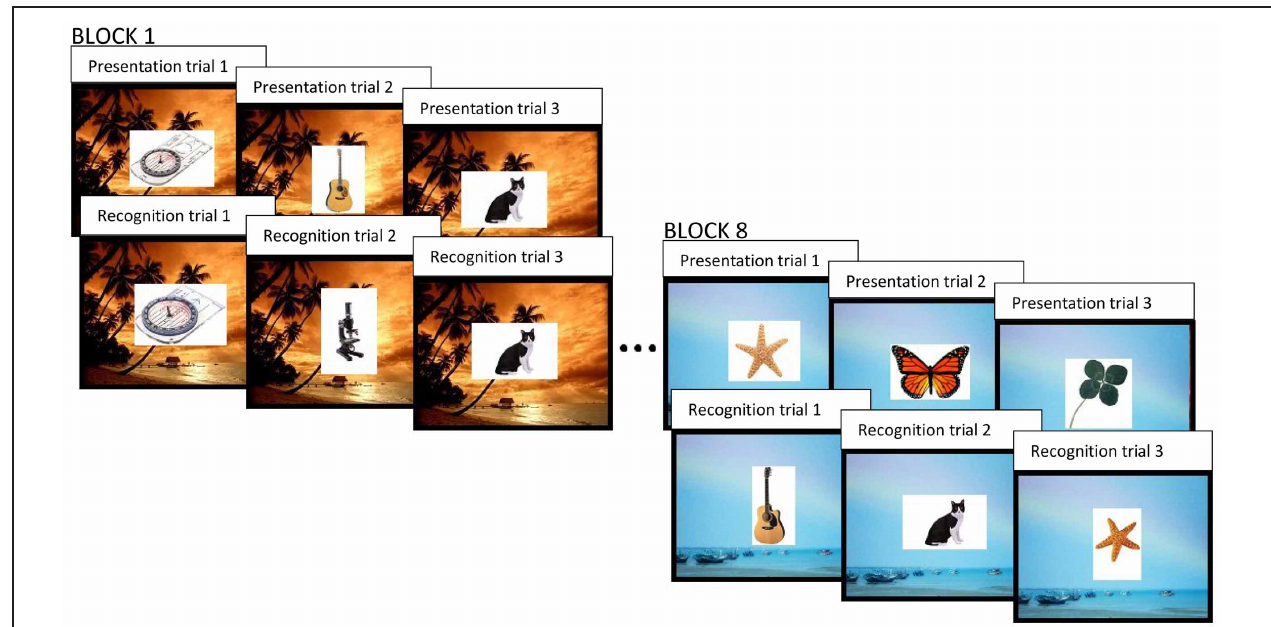
completely unrelated foil. Each block has a distinct visual context (background image). In recognition trials, for repetitions and similar items, the associated target may have been seen within the same block (same temporal and visual context) or within a previous block (different temporal and visual